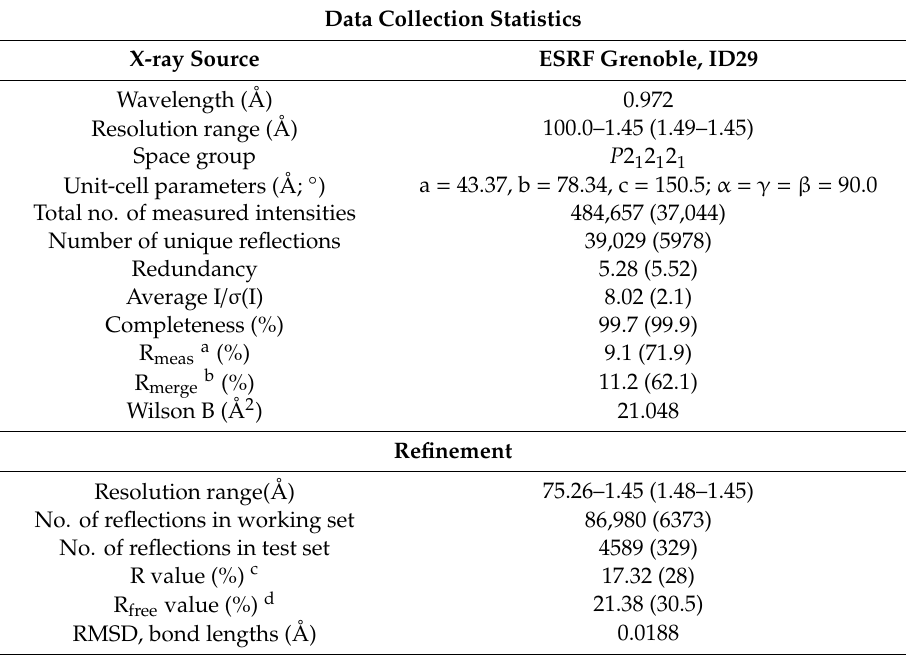
Table 1. Di ff raction data collection and refinement